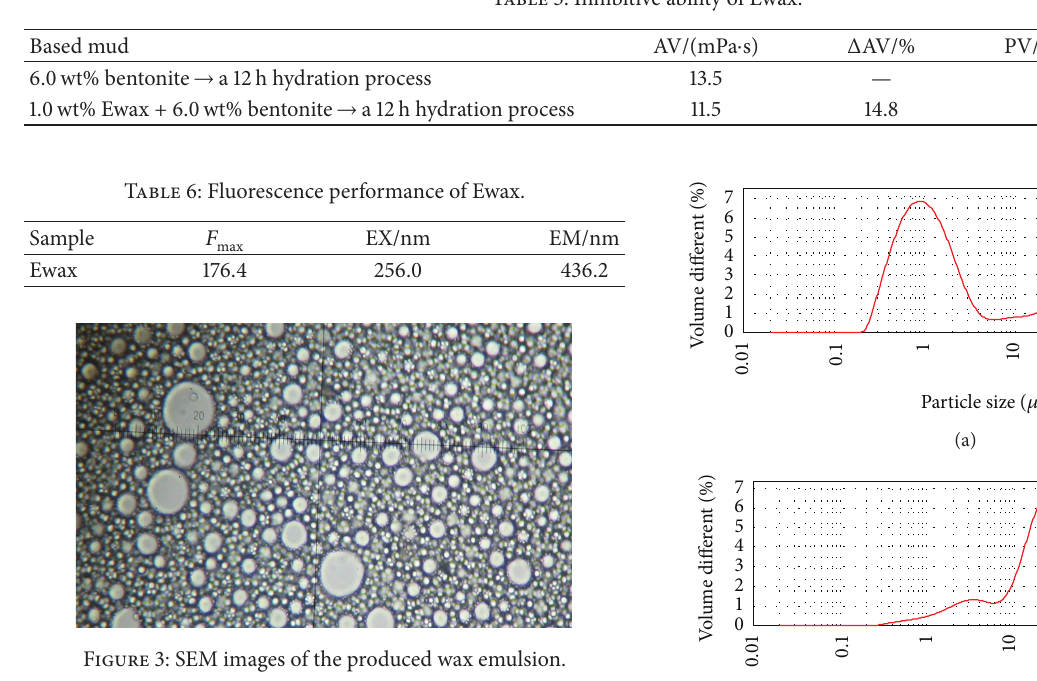
Table 5: Inhibitive ability of Ewax.